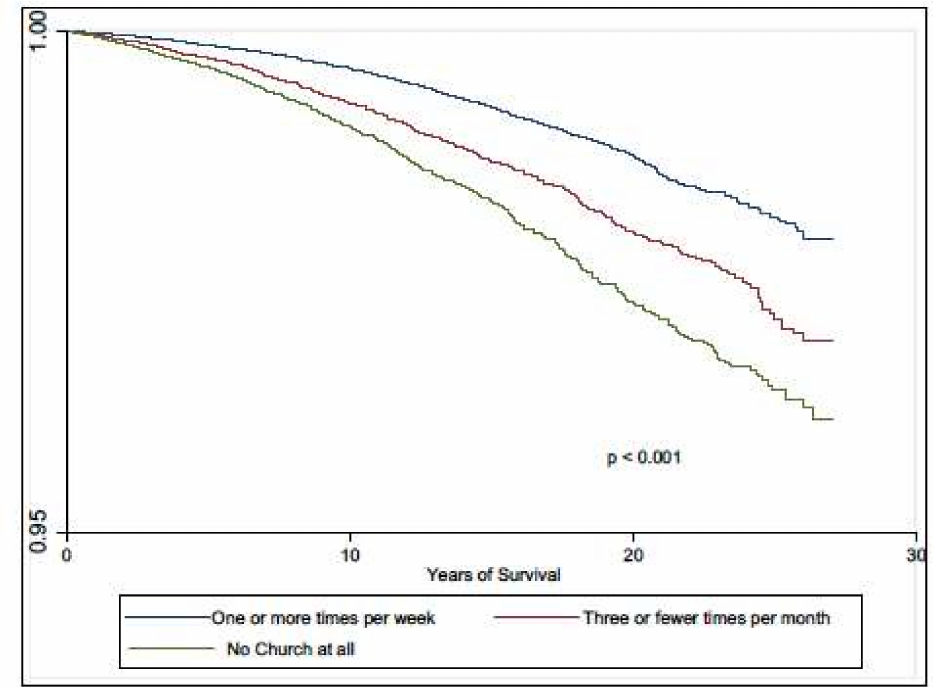
Figure 4. Age-adjusted CKD survival